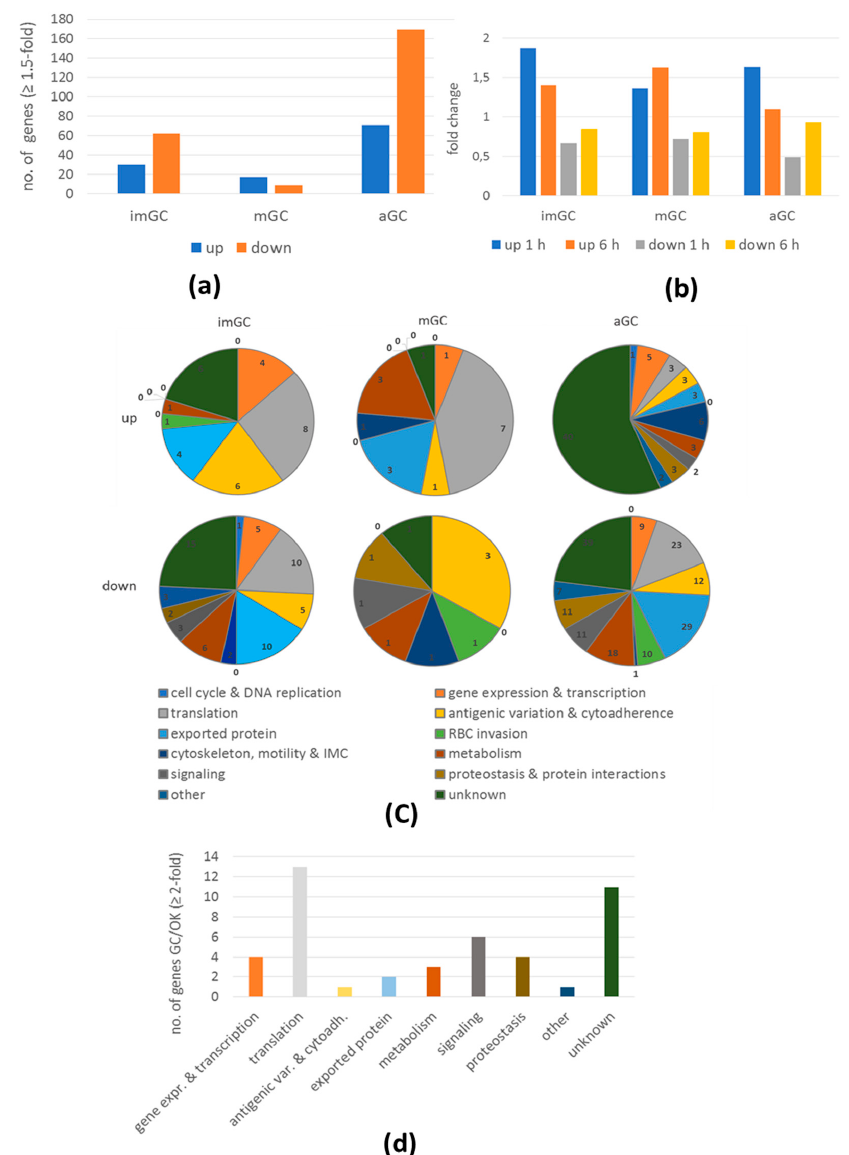
Figure 4. De-regulation of gene expression following BIX-01294 treatment of gametocytes. Immature (imGC) and mature (mGC) gametocytes as well as gametocytes at 1 h post-activation (aGC) were treated with BIX-01294 at IC 90 concentrations or 0.5% vol. DMSO (untreated) for 1 and 6 h, total RNA was isolated and cDNA synthesized to be employed in microarray assays. Genes with a relative expression levels greater than 1.5-fold for at least one of the two time-points combined with a consistent up- or downregulation for both time-points were used for further analysis. ( a ) bar charts showing total up- and downregulated genes in imGC, mGC and aGC; ( b ) bar chart showing the mean fold changes in imGC, mGC and aGC following BIX-01294 treatment; ( c ) pie chart showing detailed number of upregulated genes in gametocytes following BIX-01294 treatment based on the predicted function; ( d ) genes 2-fold downregulated in aGC with high expression in gametocytes (GC) and / or ookinetes (OK) grouped by function (according to PlasmoDB; www.plasmodb.org).